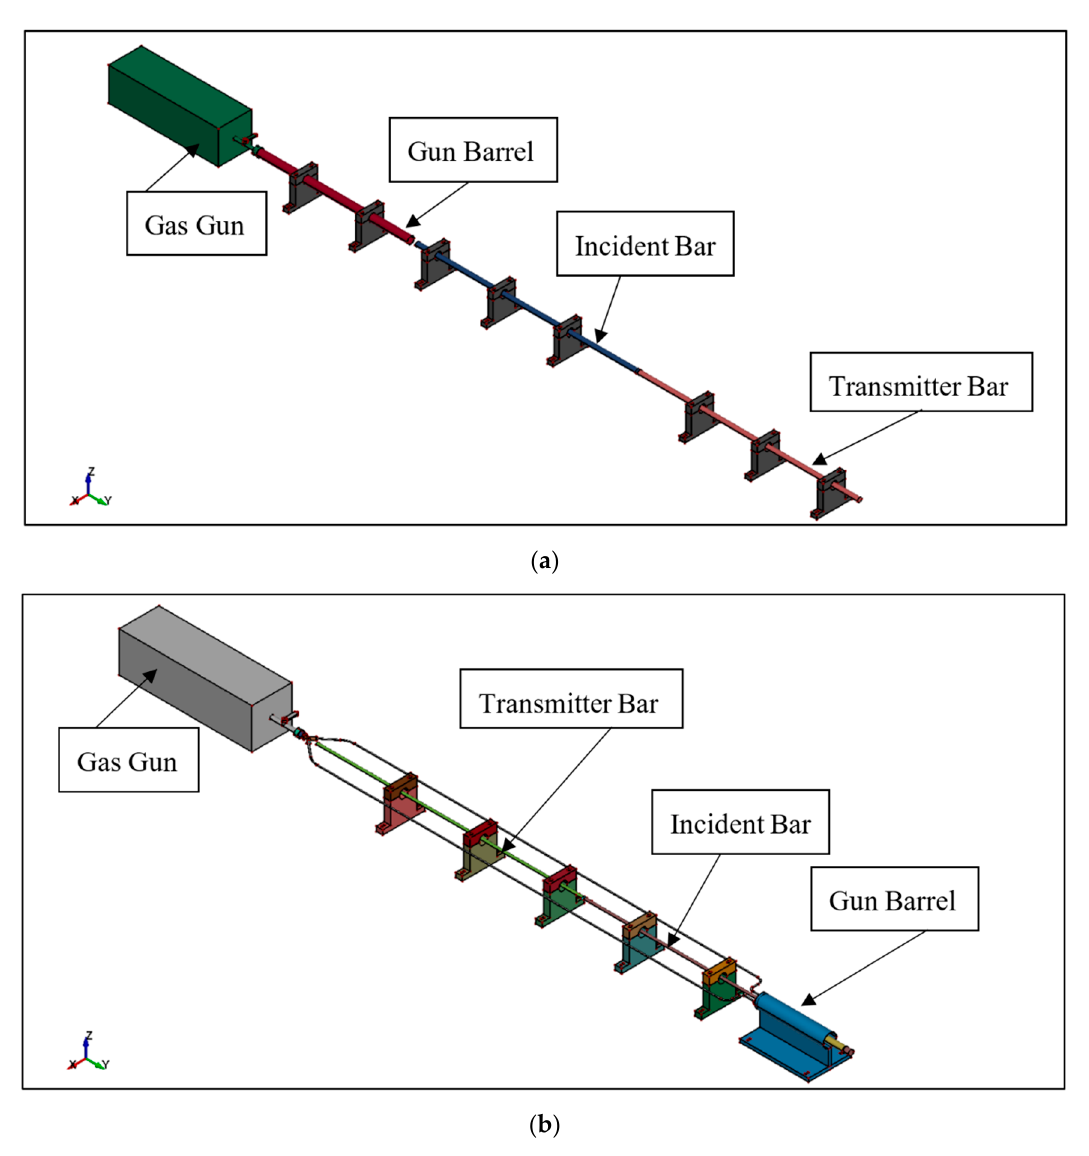
Figure 1. Modification of ( a ) the current split Hopkinson compression bar system into a ( b ) split Hopkinson tension bar.